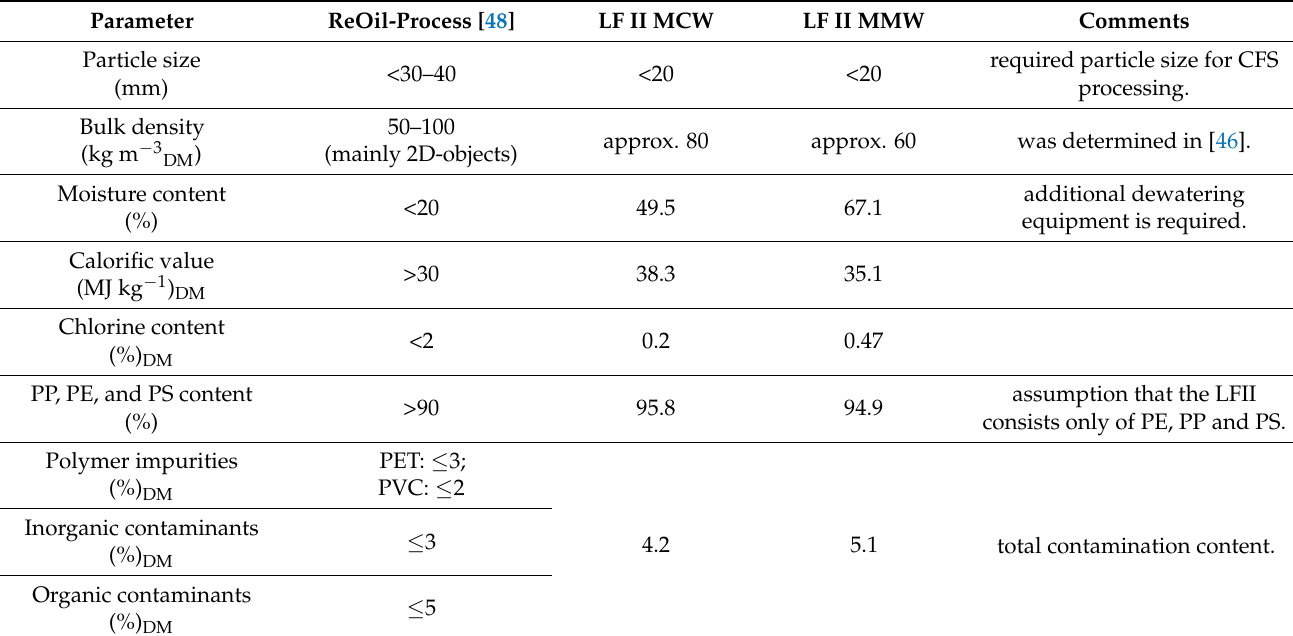
Table 3. Comparison of the measured values with the quality requirements for the ReOil process (MMW: mixed municipal waste, MCW: mixed commercial waste, CFS: centrifugal force separator)